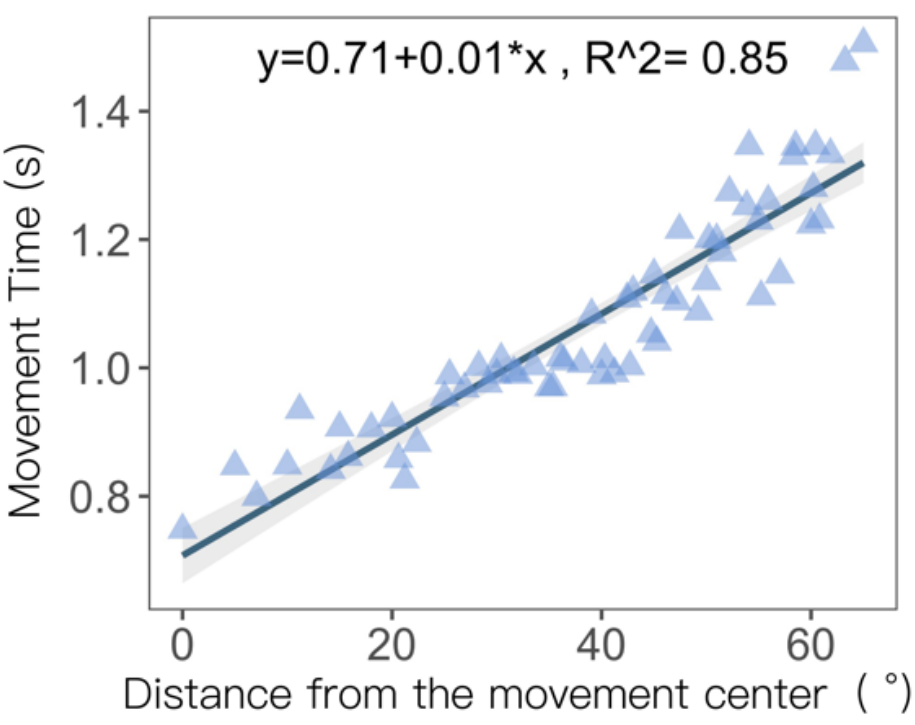
Figure 5. Correlation analysis regarding the movement time and the distance between the position of the target and motion starting center.